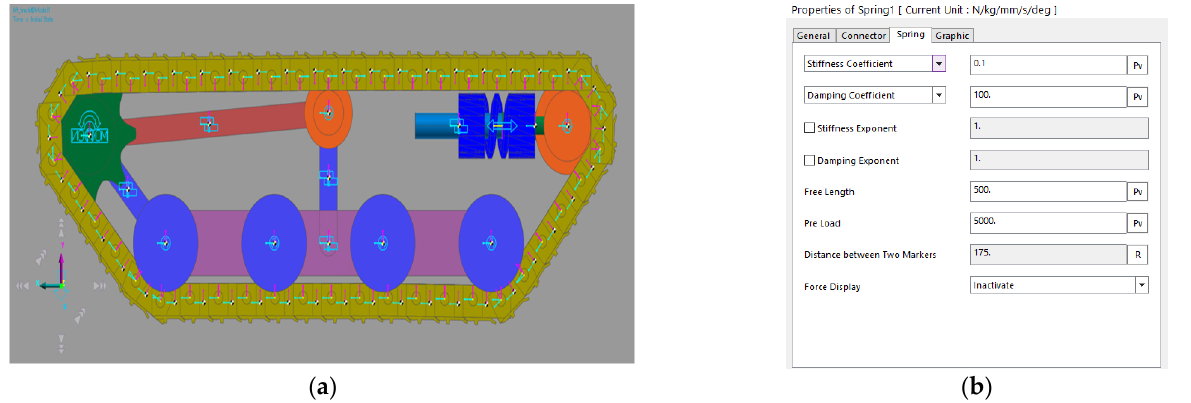
Figure 3. ( a ) Model of track section, and ( b ) properties considered for setting tension force.